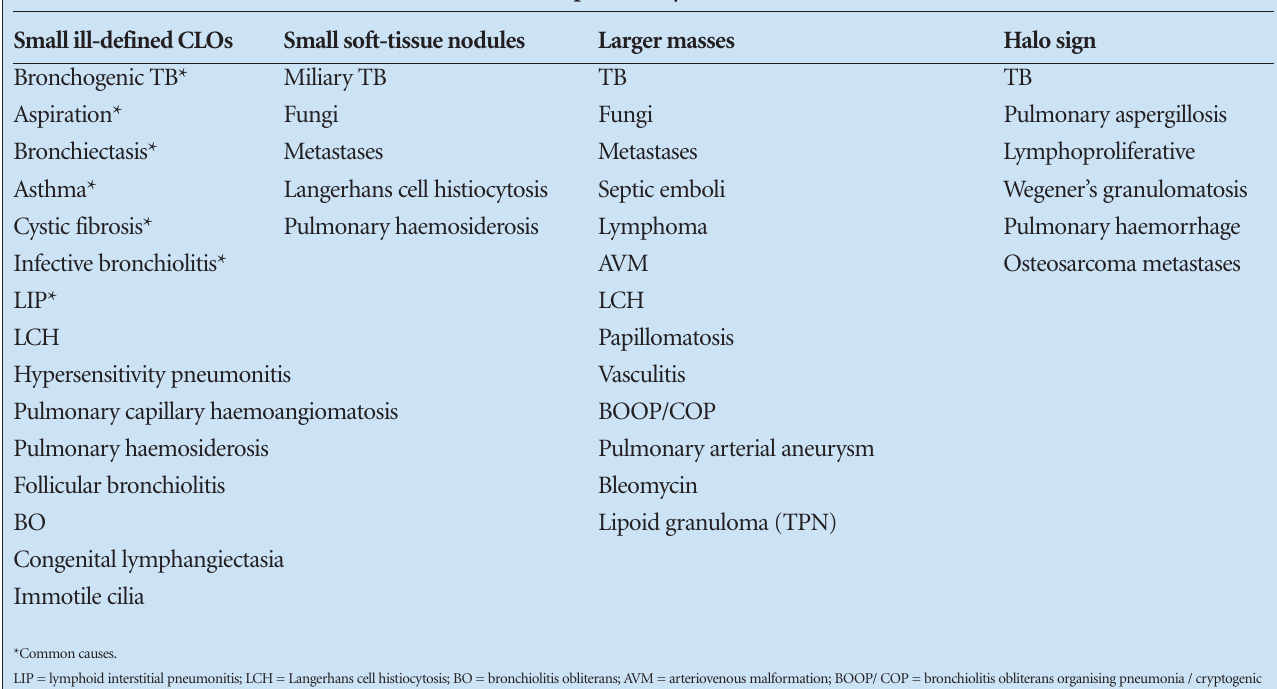
Table I. Causes of pulmonary nodules in children